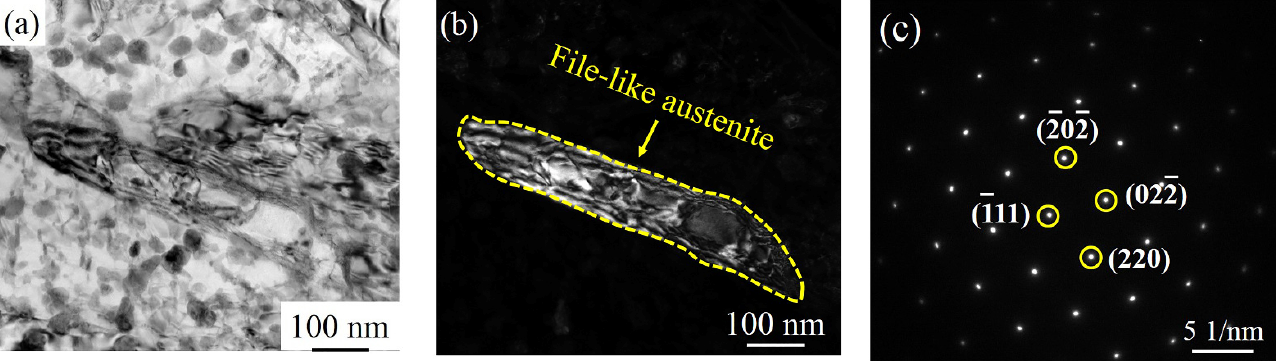
Figure 15. Distribution of Cr, Mo and Ni in the matrix of 480A-4 ( a – d ), 540A-4 ( e – h ) and 600A-4 ( i – l ).